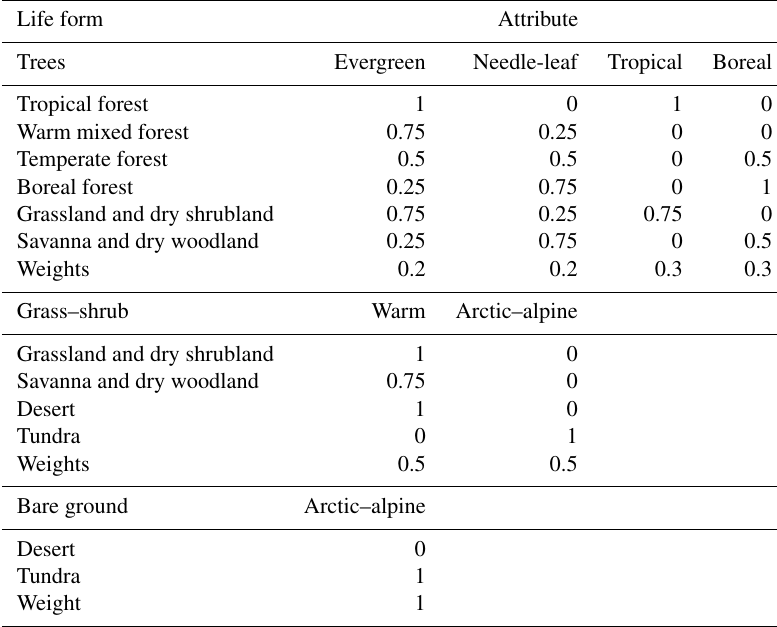
Table 5. Attribute values and the weights for plant life forms used by the (cid:49)V